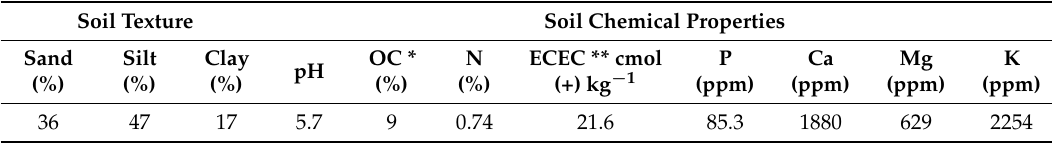
* Organic carbon, ** Effective cation exchange capacity (Sum of exchangeable basic and acidic cations). The experiment was initiated with mechanical tillage (ploughing and harrowing) (0–10 cm depth) on the 18th September. Perennial ryegrass ( Lolium perenne L. var. Samson) was sown at a density